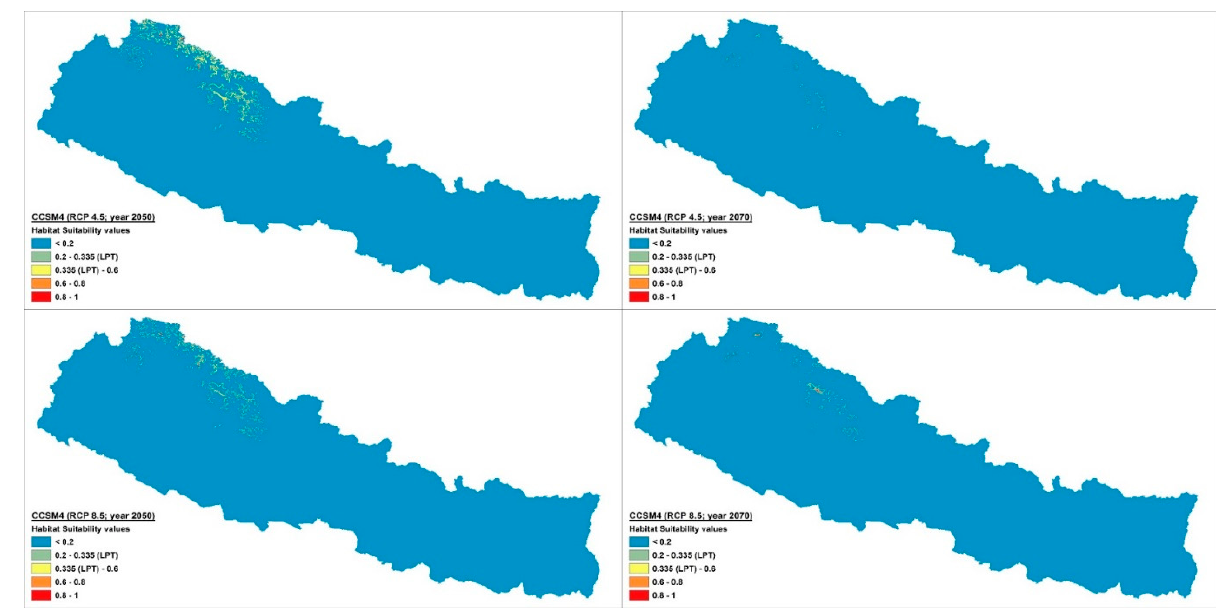
Figure 4. Climate change scenario under CCSM4 model, RCP 4.5 and 8.5 at 2050 and 2070.